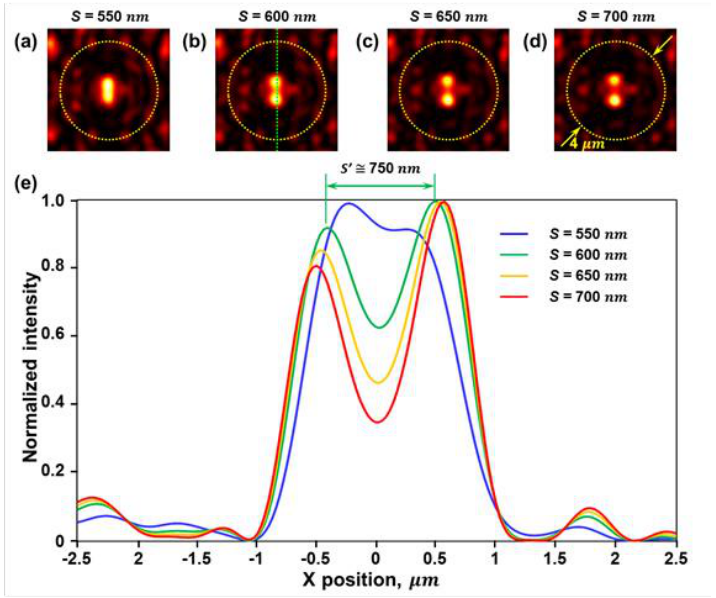
Figure 2. Imaging of two separated coherent point light sources by a 5-fold symmetry quasi-periodic nanohole array lens. Plates ( a ) to ( d ) show the calculated patterns of imaging two coherent light sources with a separation of 550 nm, 600 nm, 650 nm and 700 nm, respectively. The two point light sources of λ = 660 nm are placed at Z obj = 11.4 μm away from a 5-fold symmetry quasi-periodic nanohole array lens, while the imaged patterns are generated at Z img = 11 μm. The size of the images is 5 × 5 μm 2 and the yellow dashed circles indicate the effective imaging area of the quasi-periodic nanohole array